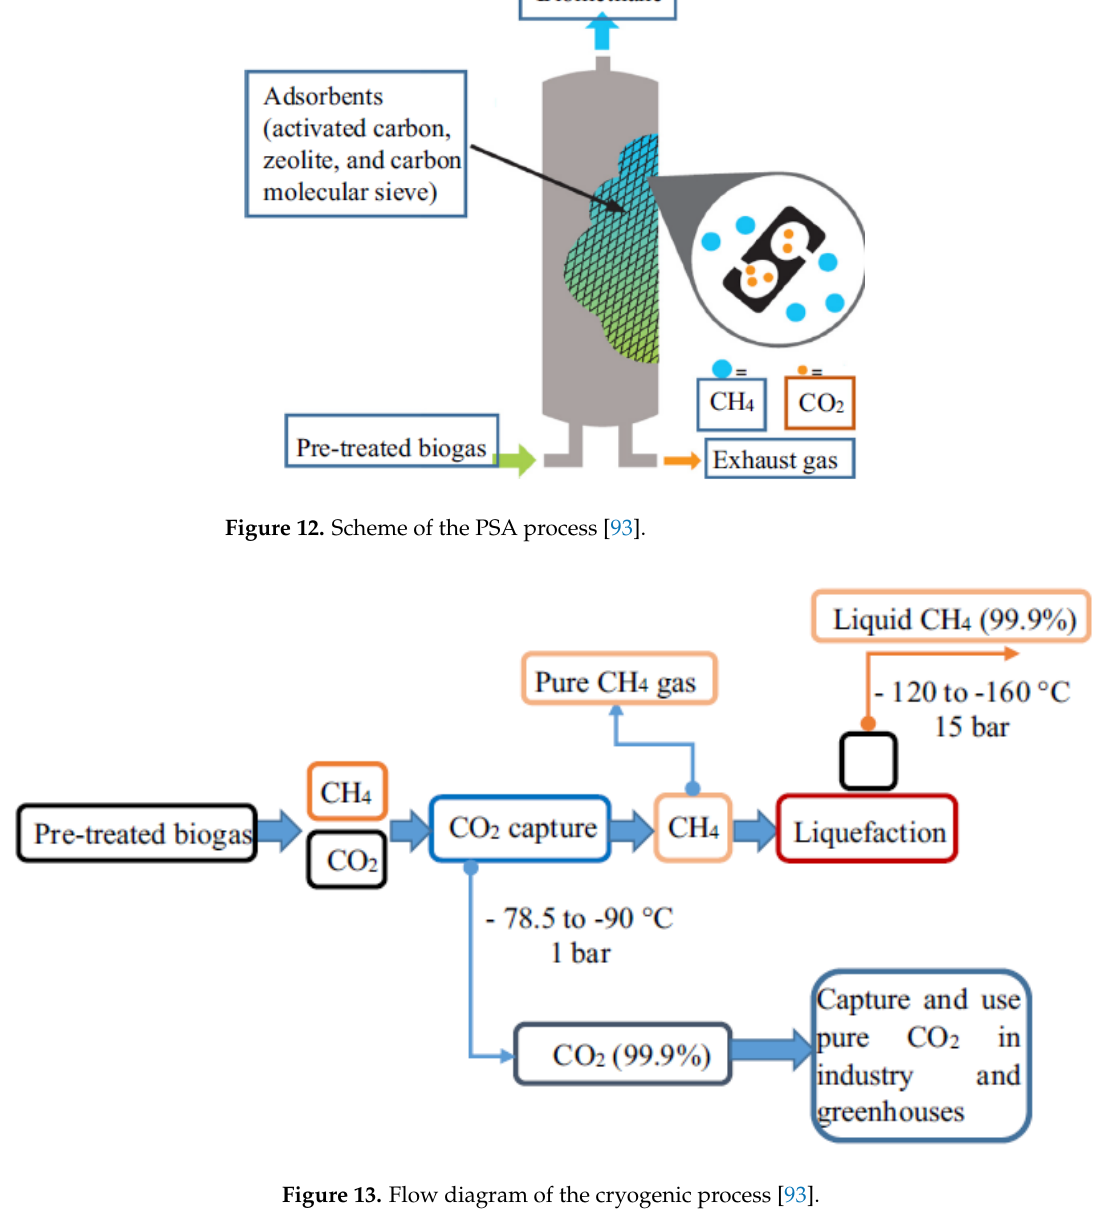
Table 3. Comparison between upgrading